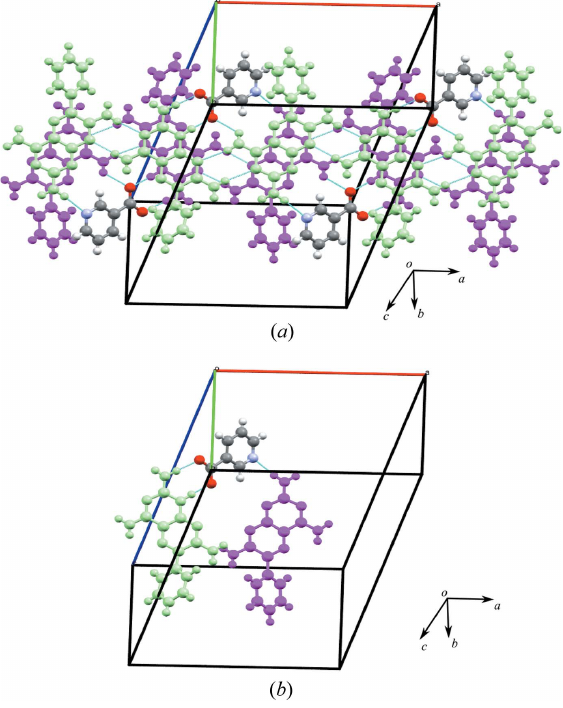
Figure 12 ( a ) Stacking of molecules of 1 to form double hydrogen-bonded chains through ( b ) nicotinic acid linkages in 1f (cid:3) DMSO.